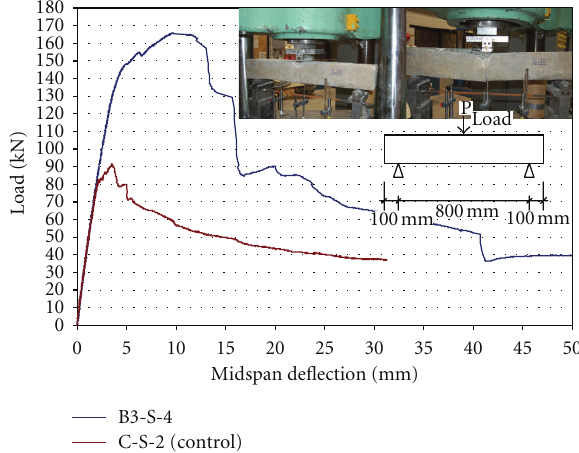
Figure 37: Load versus midspan deflection of RC beam